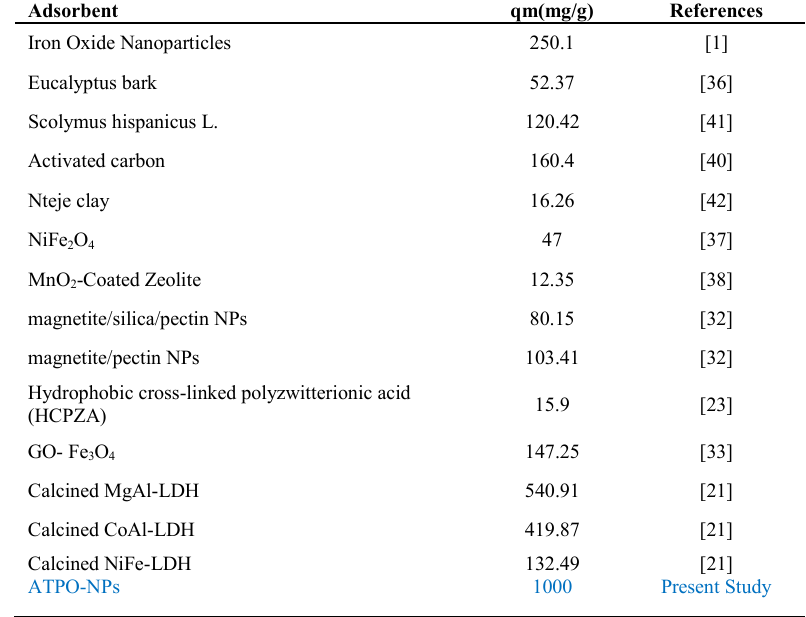
Table 5: Comparison of maximum adsorption capacities (q max , mg/g) of some adsorbents for EBT from the aqueous phase